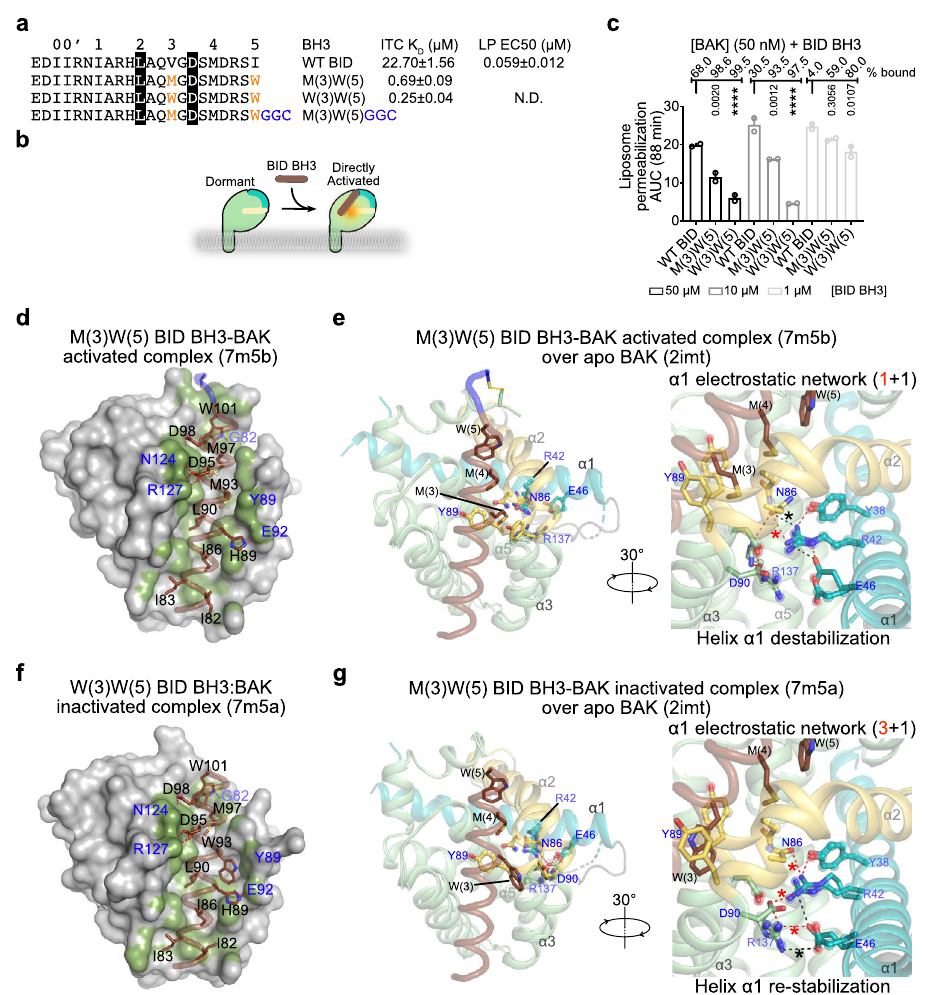
Fig. 5 BH3 ligand binding to the activation groove regulates helix α 1 stability to activate or inactivate BAK. a BH3 peptide sequences, their binding constants determined from isothermal titration calorimetry (ITC) with BAK, and EC50 values from liposome permeabilization (LP EC50). ITC traces and binding parameters are summarized in Supplementary Fig. 7a. GGC linker is for tethering the peptide to G184C of BAK. b Model for direct BAK activation. c AUC quanti fi cation of kinetic traces for liposome permeabilization in Supplementary Fig. 7c. We estimated complex formation according to % bound = ([BID BH3] × 100)/( K D + [BID BH3]). Data are presented as mean + SEM of n = 2 experiments each of n = 3 technical replicates. Adjusted p values indicated above each bar were calculated by multiple comparisons using one-way ANOVA with Tukey test; **** P < 0.0001. 95% con fi dence interval of differences are presented in the Source Data File. Cartoon:surface representation for directly activated complex ( d ) and inactivated complex ( f ) of BAK bound to BID-like BH3 peptides. Van der Waals contacts ( ≤ 4 Å) at the peptide interface are shaded green. The GGC peptide linker is colored blue (d). See also Supplementary Fig. 7 and Supplementary Table 3. e , g Overlay of apo and directly activated and inactivated BAK identifying key amino acids involved in helix α 1 stabilization. Apo residues are rendered as sticks and spheres and their electrostatic network contacts (dashed lines) are excluded. Remarkably, the electrostatic network is destabilized and re-stabilized in these complexes, respectively, compared to that observed in apo BAK. Hydrogen bonds ≤ 3.2 Å (red) and ≤ 3.6 Å (black) between helix α 1 and the rest of the domain identi fi ed with * are summarized in brackets, Supplementary Fig. 7g, i, and Supplementary Table